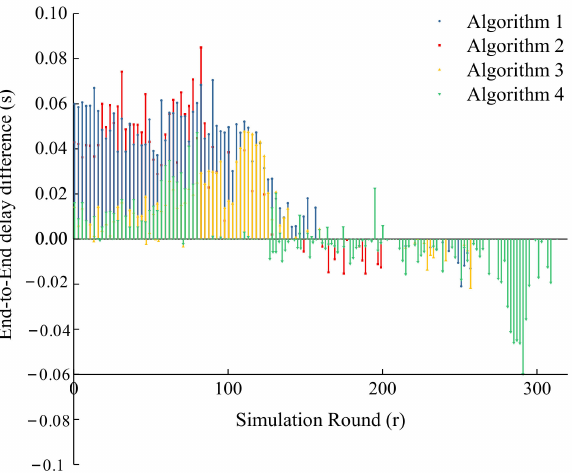
Figure 6. End-to-End delay